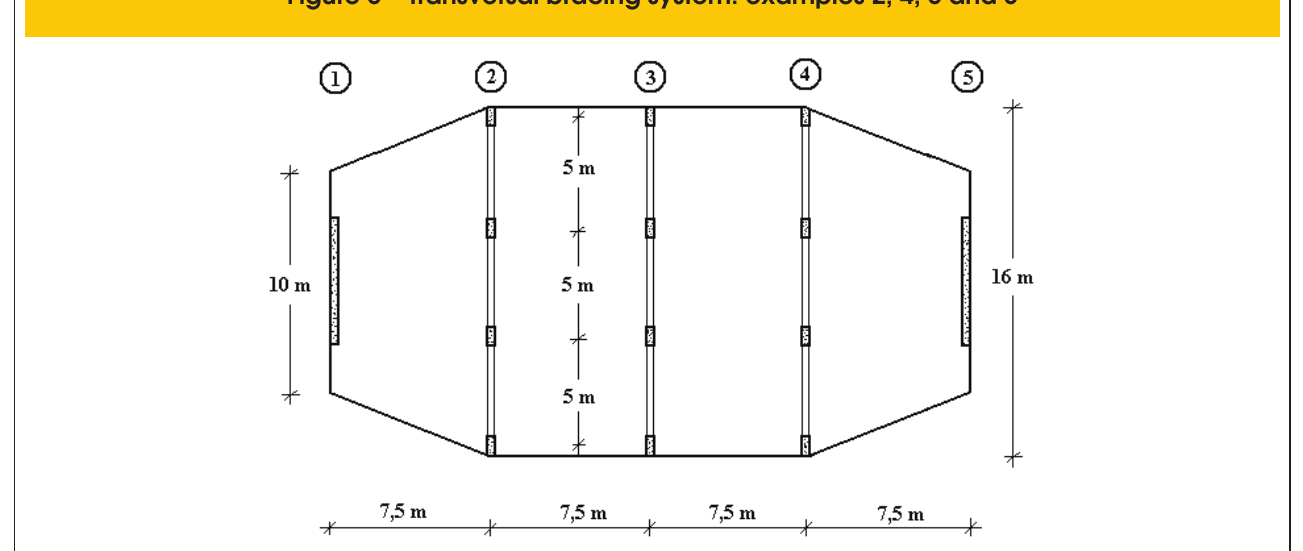
Figure 6 – Transversal bracing system: examples 2, 4, 6 and